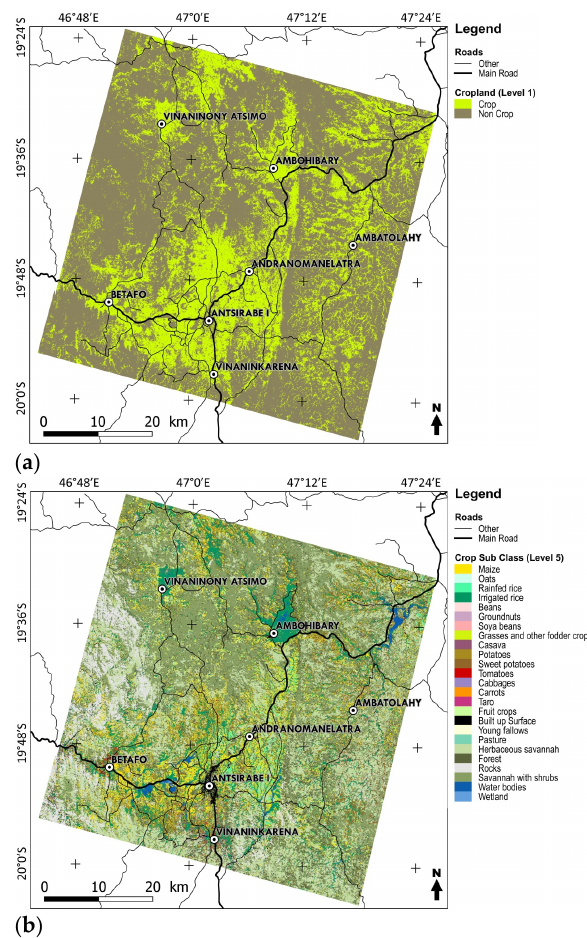
Figure 5. Maps obtained at level 1, cropland ( a ), and level 5, crop subclass ( b ), via the hierarchical classification approach. classification